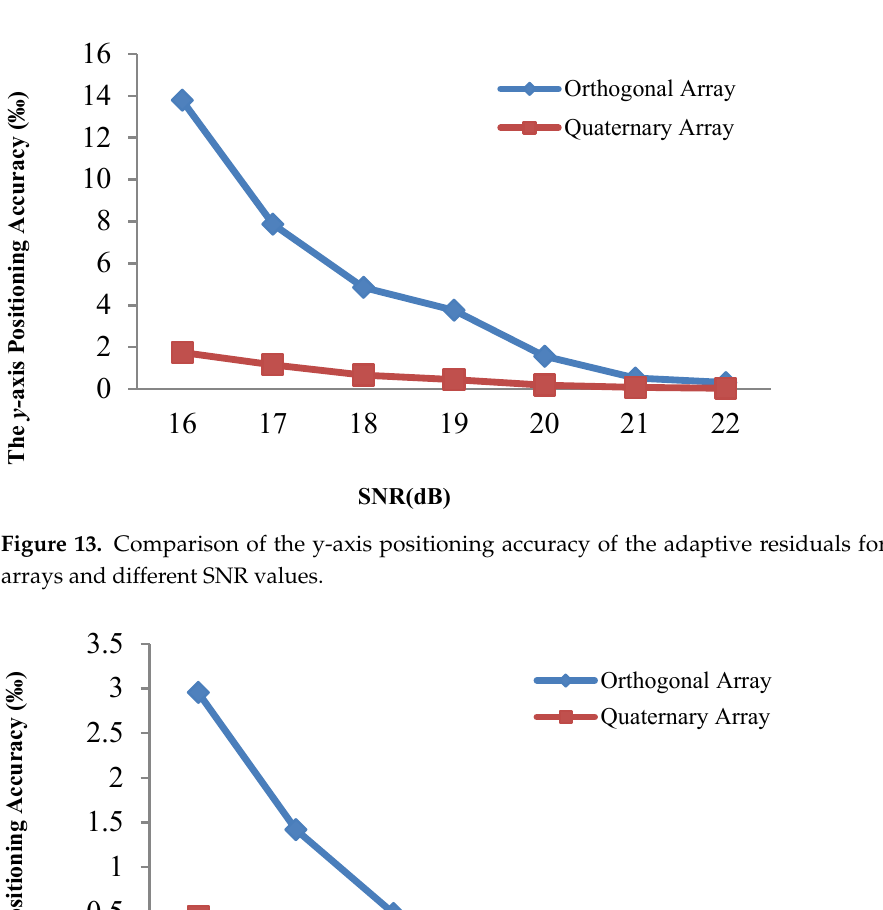
Figure 15. Comparison of the y-axis positioning accuracy of the Kalman filtering for different ar- rays and different SNR values. 4.6.2. Discussion on the Positioning Accuracy of Different Methods Figures 8 and 10 demonstrate that the proposed positioning method could gain a higher accuracy regardless of the kind of array. More specifically, with the traditional array, compared with the adaptive residuals and the adaptive algorithm positioning